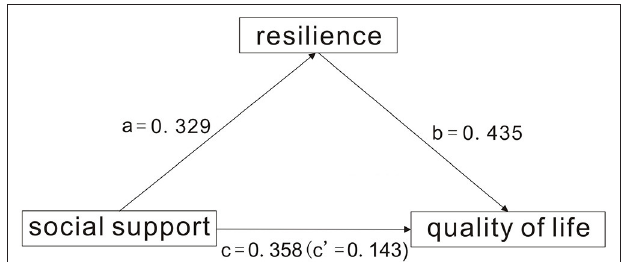
FIGURE 1 | The model of mediation for the impact of social support toward quality of life in glaucoma with the mediation impact of resilience.